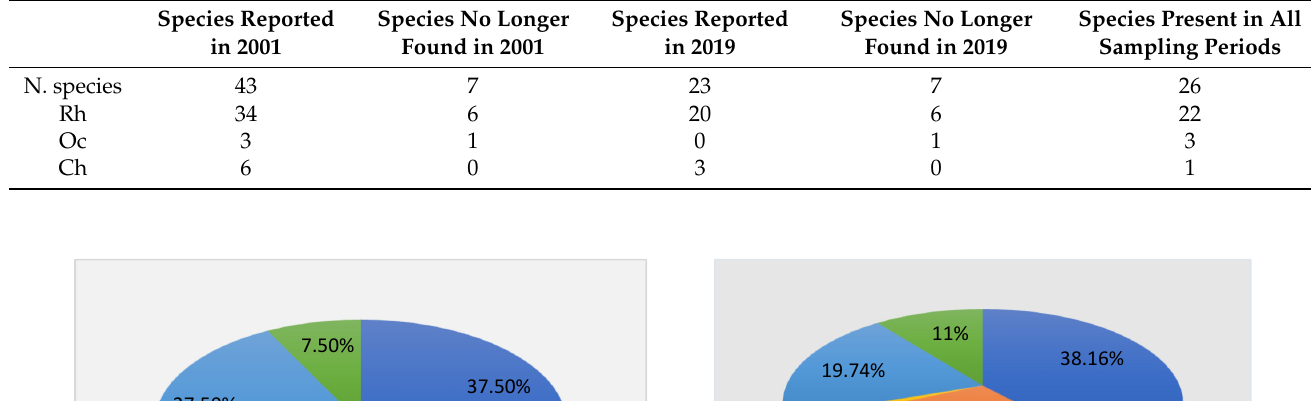
Table 4. Variations in the number of species, Rhodophyta, Ochrophyta, and Chlorophyta observed from the 1970s to 2019 in the coralligenous flora of the MPA.